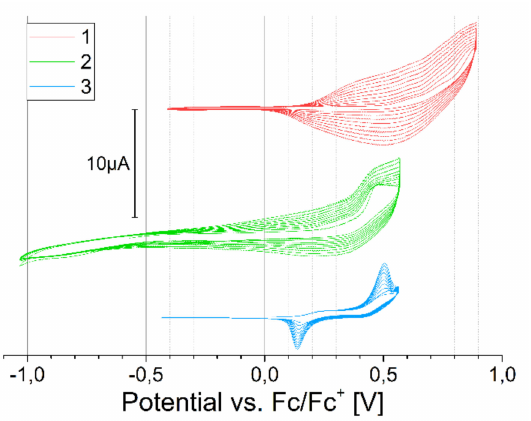
Figure 6. Cyclic polymerization versus ferrocene redox couple, concentration 2 mmol / dm 3 in DCM, 100 mV / s.